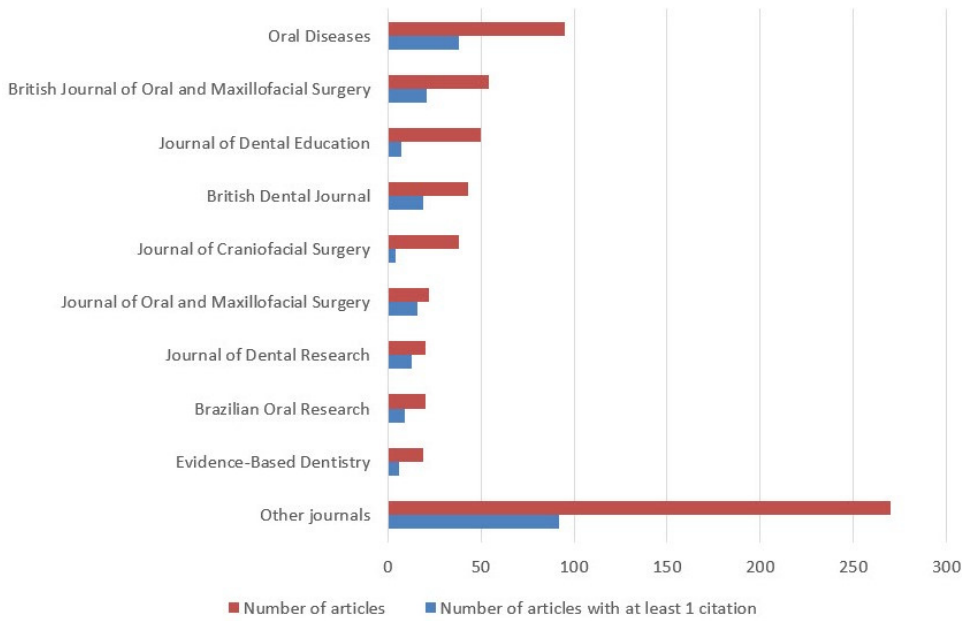
Figure 2. Dental journals with the highest number of COVID-19 articles.